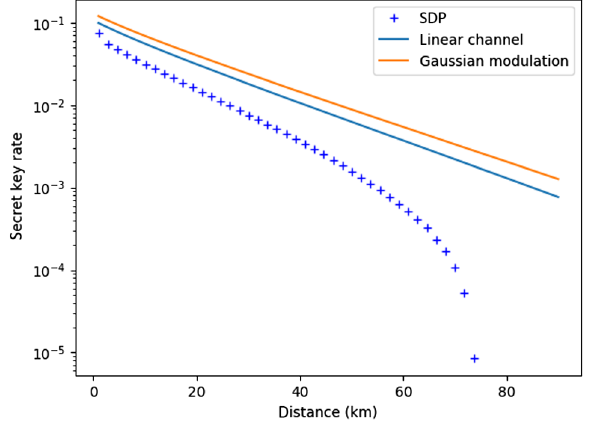
FIG. 5. Secret key rate versus α , for a distance of 50 km and excess noise of ξ ¼ 0 . 002 . Other parameters are the same as in Fig. 2.